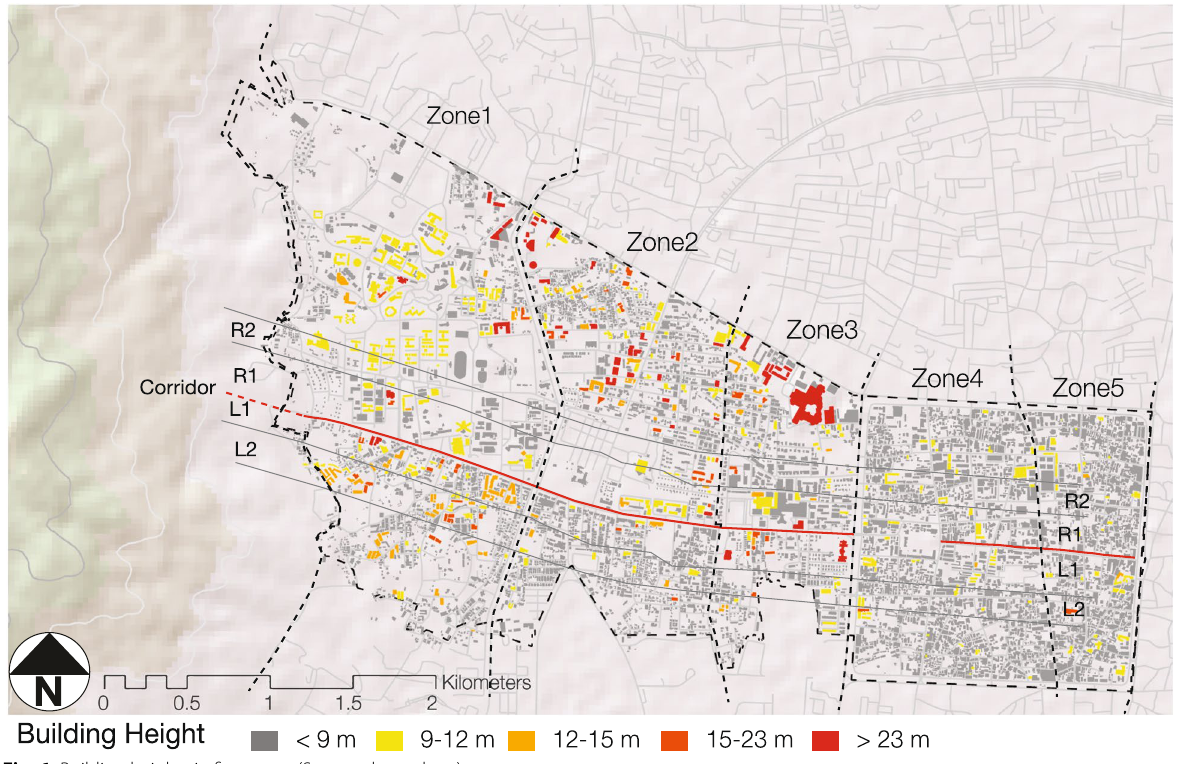
Fig. 6 Building heights in five zones (Source: the